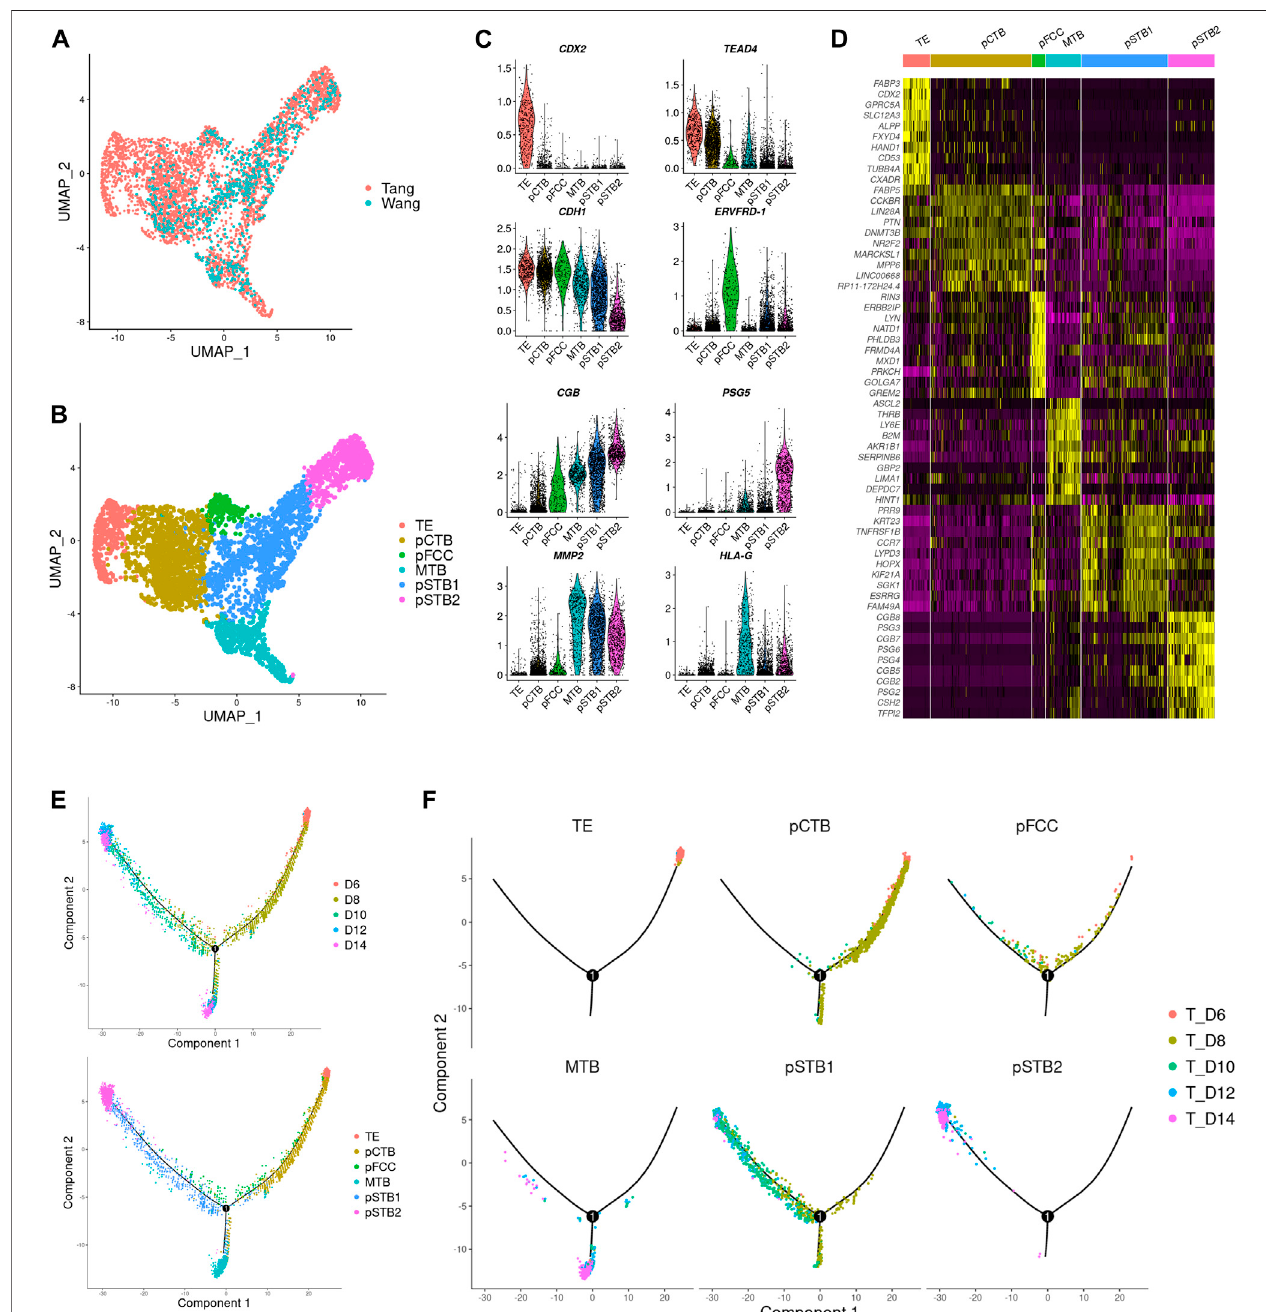
FIGURE2| Distinctsubtypesinearlytrophoblastcellsduringimplantation. (A) Jointvisualizationofourdatasetstogetherwithpublisheddatasets.Tangrepresents published datasets; Wang represents our datasets. (B) UMAP plots showing the expression patterns of early trophoblast cells in different clusters. TE, trophectoderm; pCTB, primitive cytotrophoblast; pFCC, primitive fusion-competent trophoblast cells; MTB, migrative trophoblast cells, pSTB1, primitive syncytiotrophoblast 1; pSTB2, primitive syncytiotrophoblast 2. (C) Violin plots showing the markers expression of different clusters. (D) Heat map showing representative DEGs in different clusters. Color key from purple toyellowindicates relative expression levels from low to high, respectively. (E,F) Pseudotime analysis was assigned to each cell showing embryonic day and lineage assignment, with cells colored by embryonic day (upper) and cell clusters (lower). Three-dimensional diffusion map representation of all cells at different culture time points, showing lineage assignment on each embryonic day (F) .